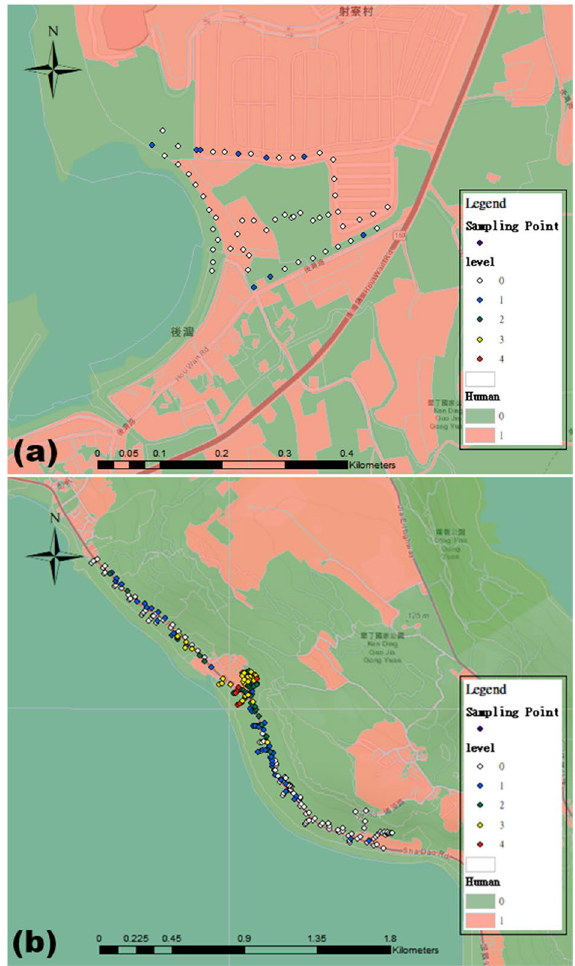
Figure 6. The distribution or abundance of Anoplolepis gracilipes in relation to proximity to human-developed land around Houwan ( a ) and Hsiangchiaowan-Shadao-Natural Spring ( b ) areas. Area of human-disturbed land and undisturbed land was represented by peach color and green color, respectively. Each sampling point was denoted by filled diamond where different colors were used to indicate quantitative differences in the average of worker abundance score (white = abundance score 0; blue = abundance score 0 < x < 1; green = abundance score 1 ≤ x < 2; yellow = abundance score 2 ≤ x < 3; red = abundance score 3 ≤ x < 4). Original copyright source: